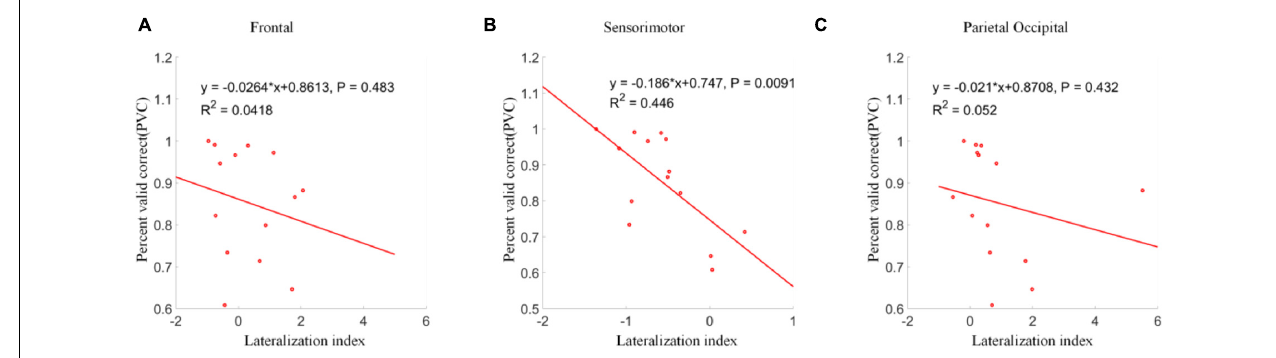
FIGURE 12 | Linear regression analyses between lateralization indexes and PVCs. (A) Frontal area. (B) Sensorimotor area. (C) Parietal occipital area. A significant linear correlation was only shown between lateralization indexes and PVCs in sensorimotor area.